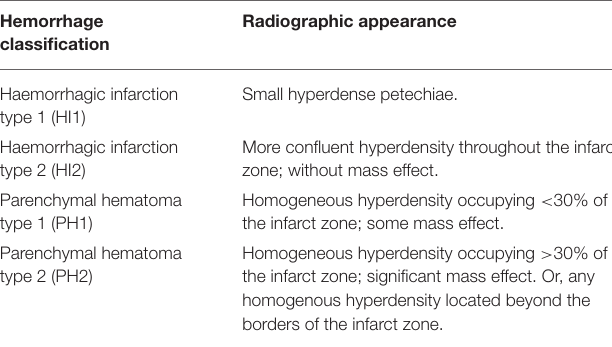
TABLE 1 | The european cooperative acute stroke study classification of hemorrhagic transformation. Hemorrhage